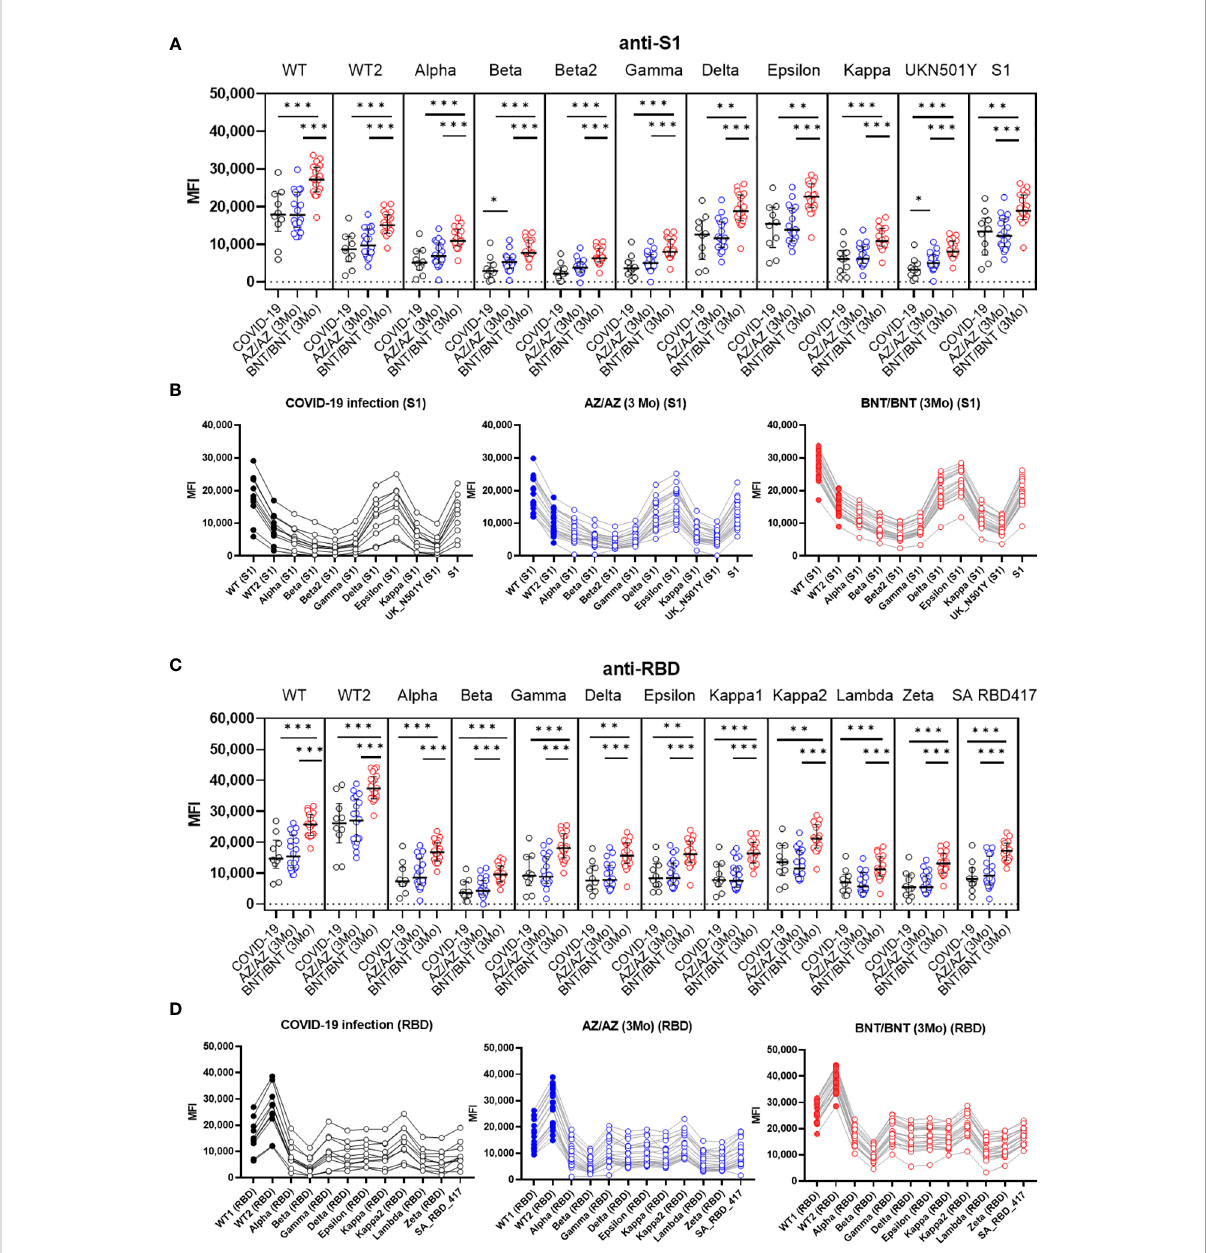
FIGURE 4 Comparison of anti-S1 (A, B) and anti-RBD (C, D) antibody levels against new variant spike antigens after COVID-19 infection (>21 days) (n=10) and 3 months after boost vaccination (AZ/AZ n=20, BNT/BNT n=20). Antibody levels were measured using microbeads coated with different new variant spike antigens (11 beads for anti-S1, 12 beads for anti-RBD) in a multiplex immunoassay. The same sera from 50 individuals were used in A-D. (A) BNT/BNT group (red) showed higher antibody levels than AZ/AZ group (blue) or COVID-19 patients (black) for all antibodies to different S1 antigens (P < 0.05). The AZ/AZ group showed higher levels of anti-S1 antibodies to beta S1 and UKN501Y antigens than those of COVID-19 patients (P < 0.05). (B) Comparison of antibody levels against different S1 antigens in three groups. (C) BNT/BNT group (red) showed higher antibody levels than AZ/AZ group (blue) or COVID-19 patients (black) for all antibodies to different RBD antigens (P < 0.05). (D) Comparison of antibody levels against different RBD antigens in three groups. *<0.5, **<0.01,